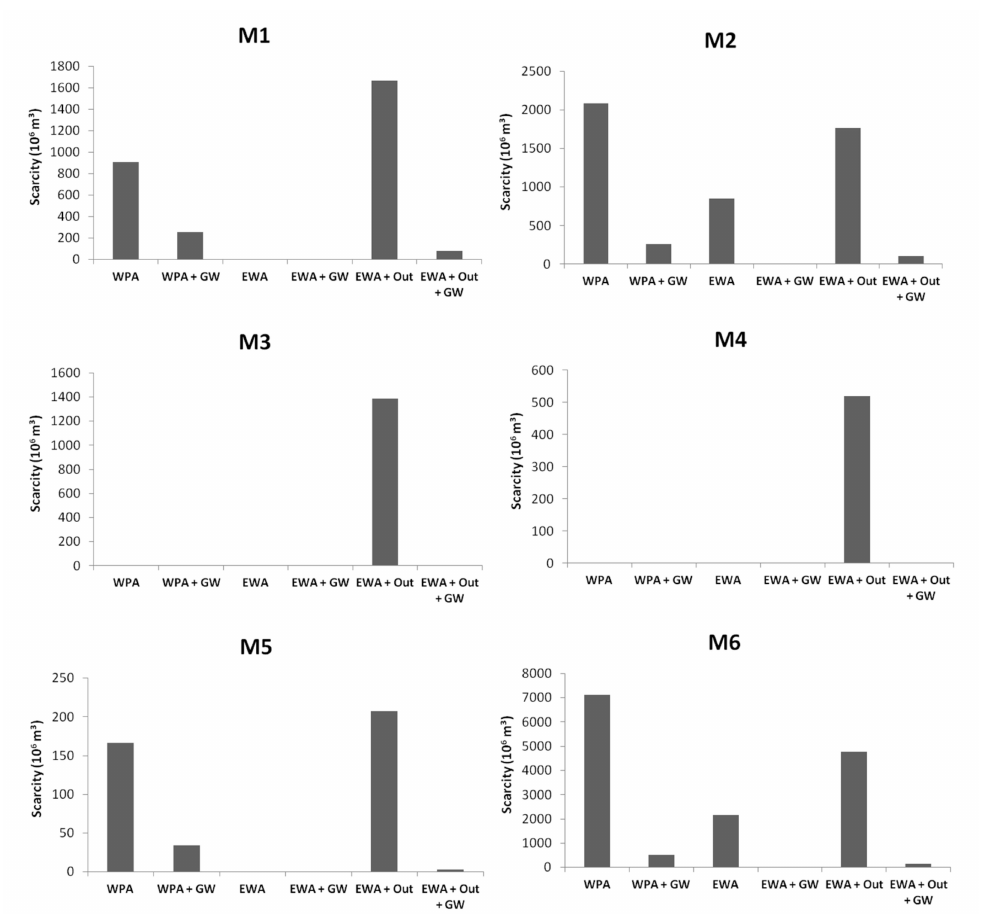
Figure 5. Scarcity (10 6 m 3 ) comparison of all scenarios simulated in each